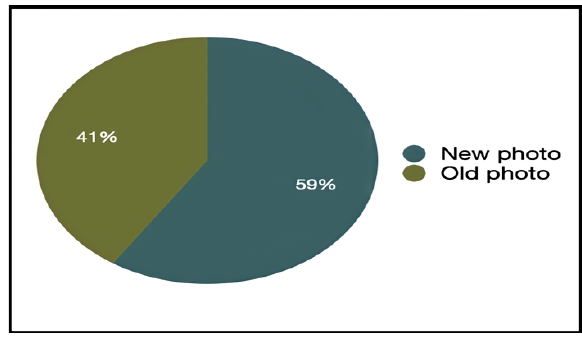
Figure 13. Image Type.